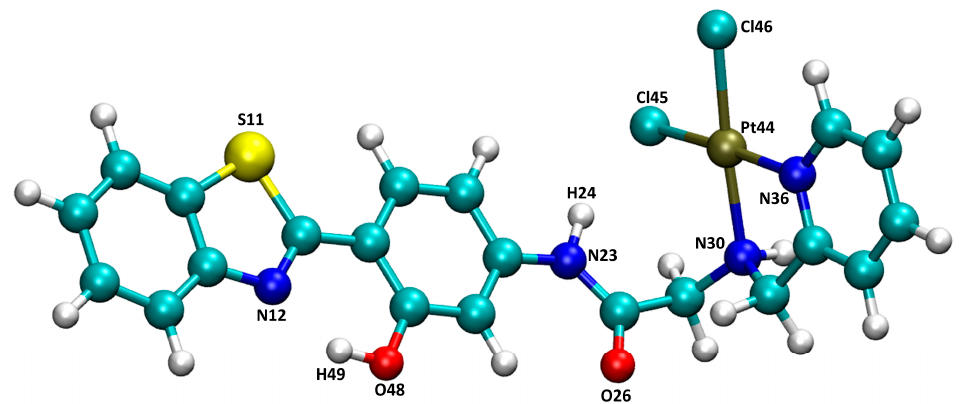
Figure 1. Three-dimensional structure of the cis -dichloro(2-aminomethylpyridine) platinum(II) bonded to 2-(4 ′ -amino2 ′ -hydroxyphenyl)benzothiazole (AHBT).